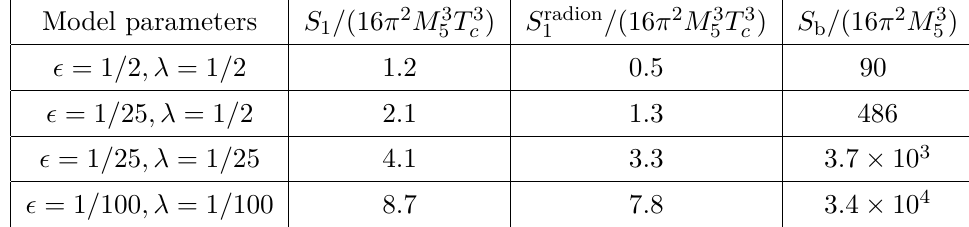
(eq. (4.3)) for different 1 , we set the lower integration limit 1